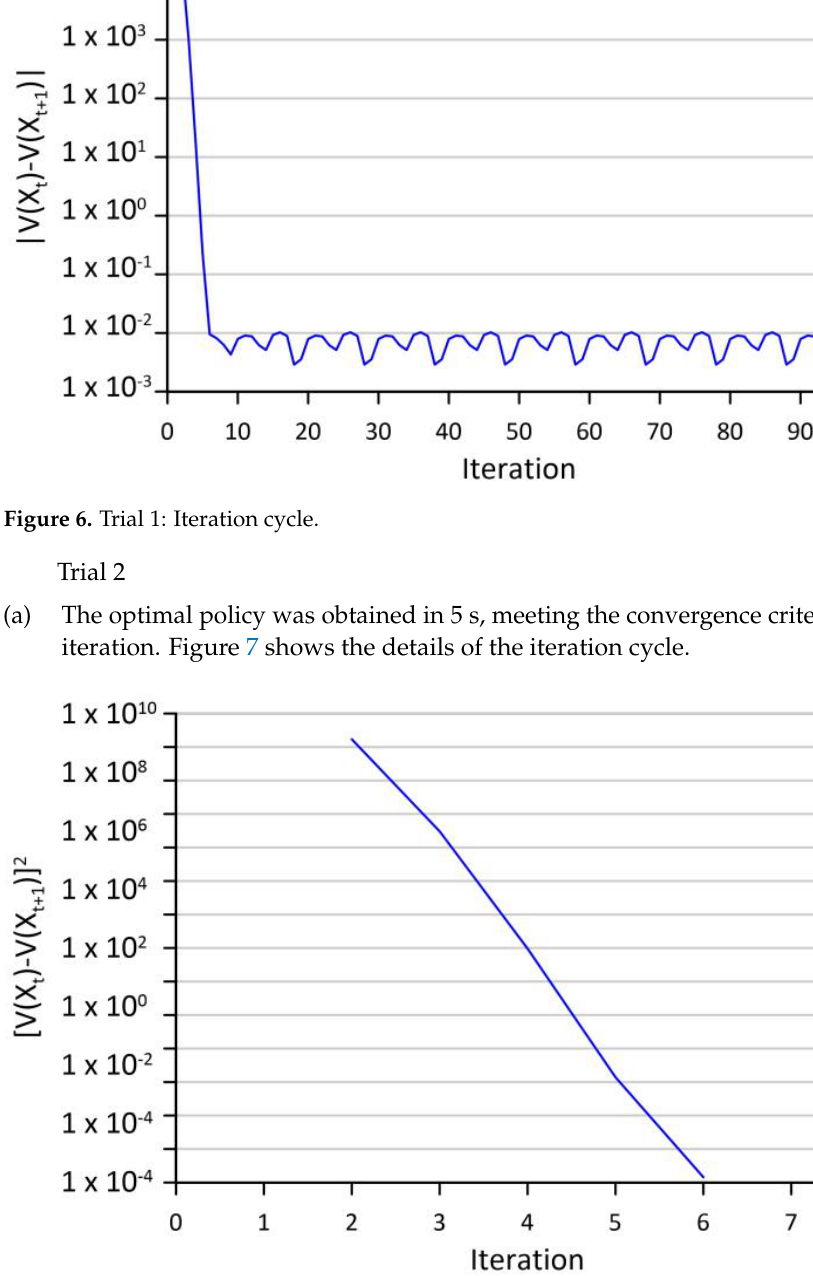
Figure 7. Trial 2: Iteration cycle.